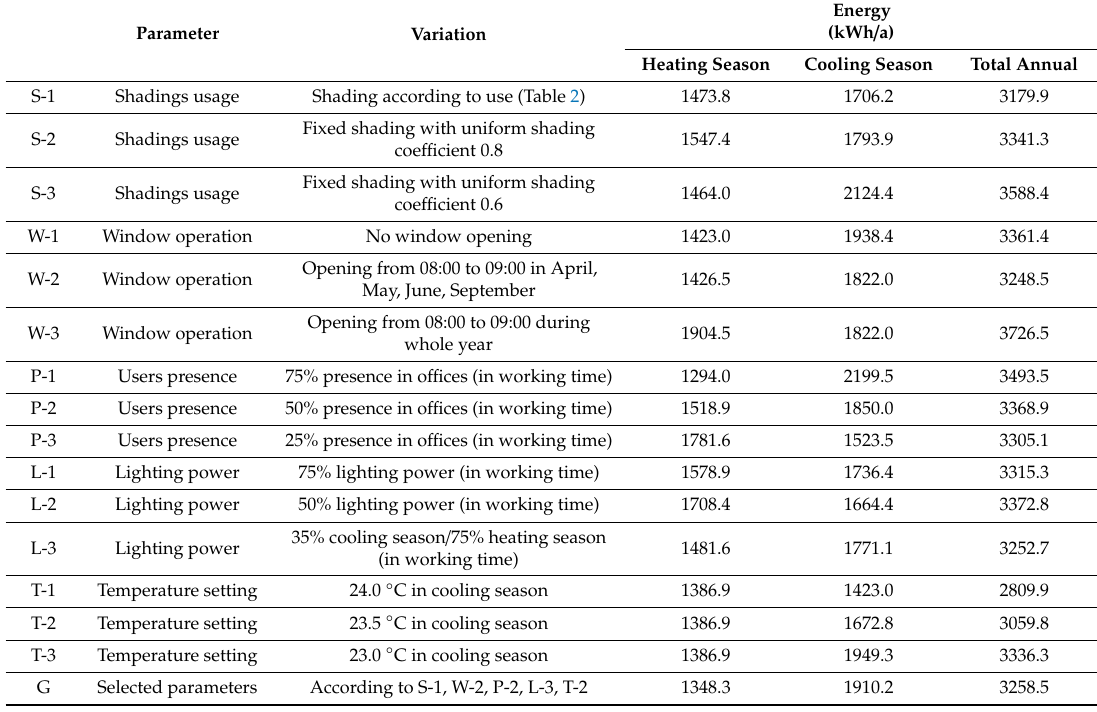
Table 2. Results of energy simulations for variations of the parameters of the validated model (S-1 to T-3) and for the validated model with the final combination of selected parameters (G) at annual level.